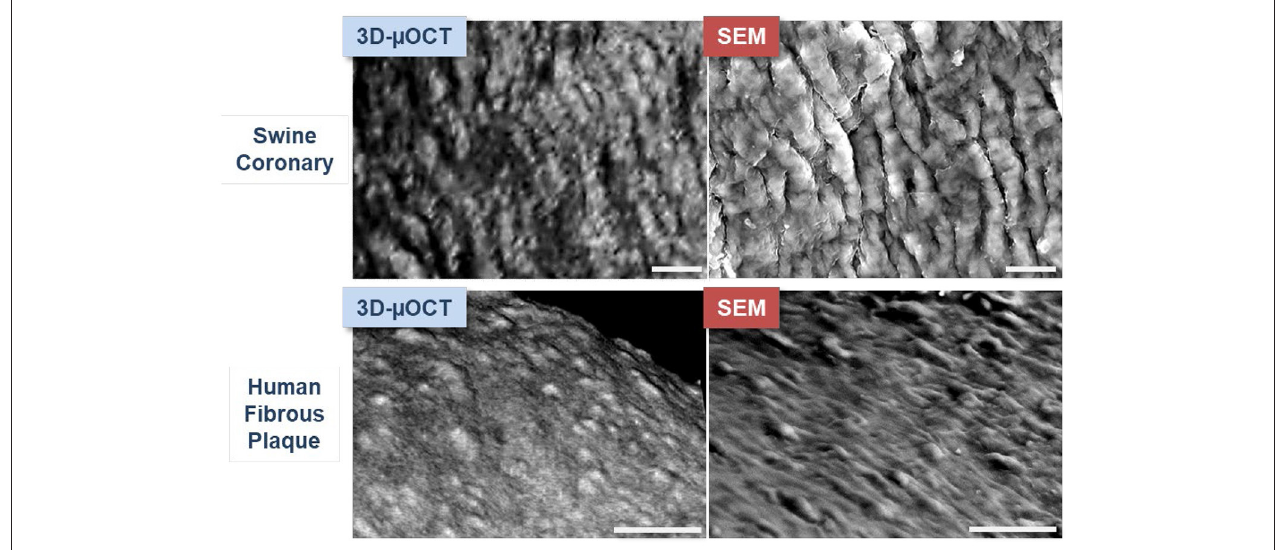
FIGURE 1 | µ OCT images of endothelial pavementing and corresponding SEM in swine and human coronary arteries ex vivo. Upper panels: Swine coronary endothelial pavementing visualized by three-dimensionally (3D) volume-rendered µ OCT is similar to that seen by scanning electron microscopy (SEM). Lower panels: Findings were consistent in human coronary fibrous plaque. Scale bars, 25 µ m. Figure and capture reprinted with permission from Nishimiya et al.